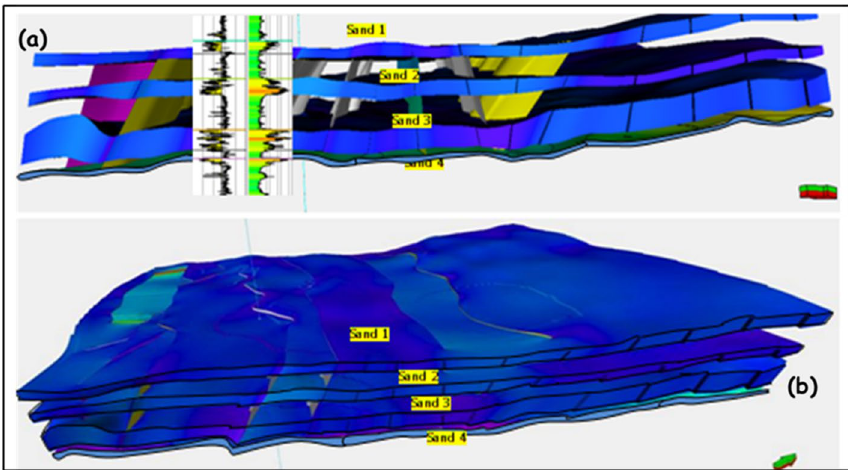
Fig. 20 a Cross-section of the mapped reservoir depth/thickness model. b 3-D view cross-section of mapped reservoir thickness